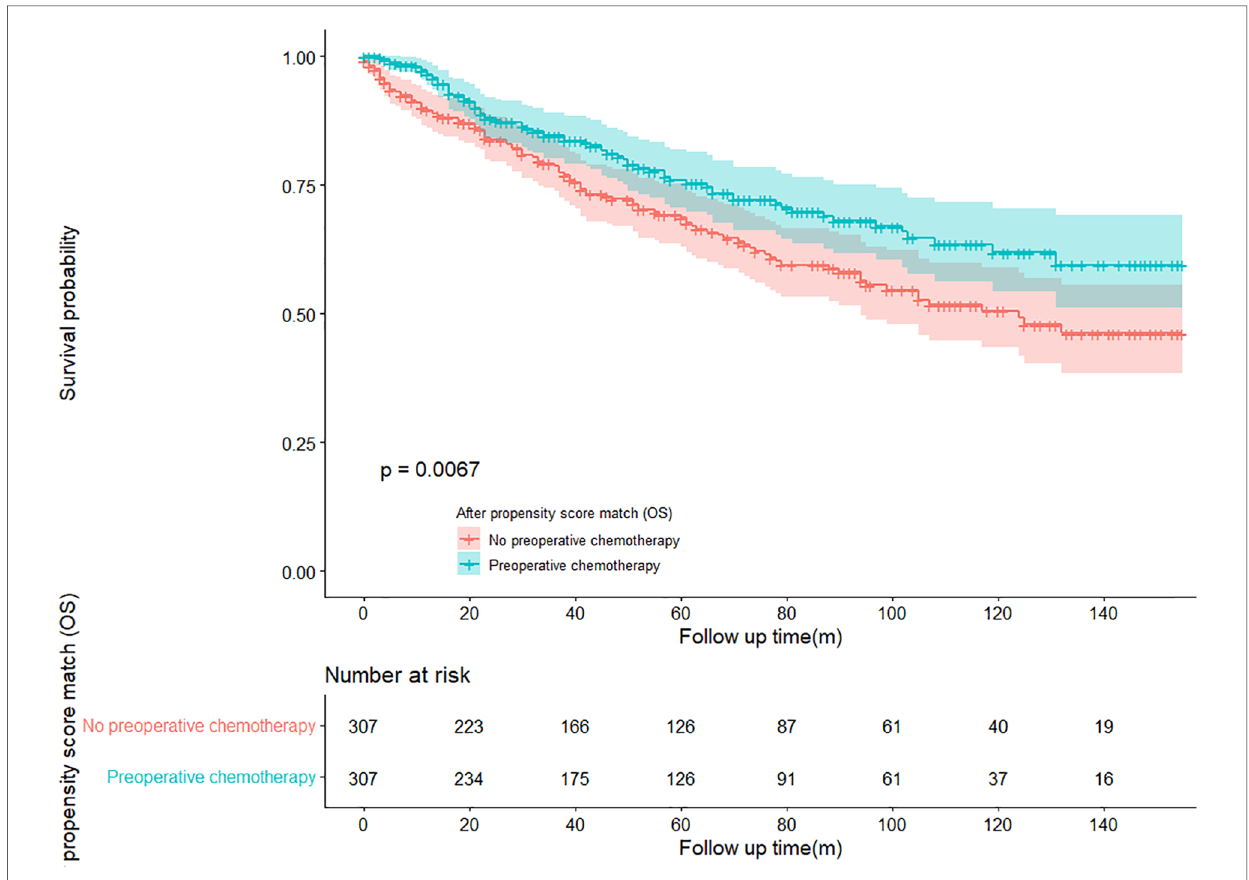
FIGURE 5 Survival curves of OS in the POCT group and no-POCT group in patients undergoing surgery for TETs after propensity